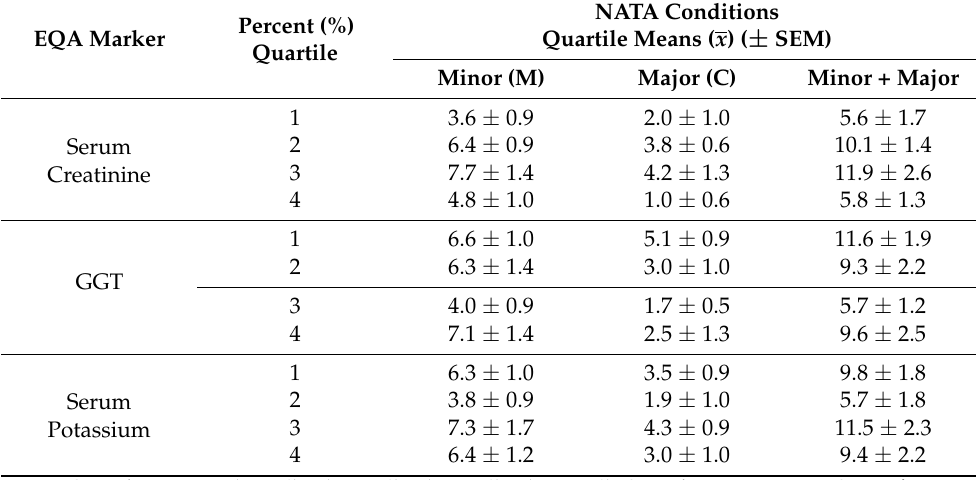
Table 1. EQA quartile (%) rankings of laboratories according to: ( a ) serum Creatinine, ( b ) GGT and ( c ) serum Potassium, and matched with the Mean ( x ) NATA conditions for each quartile (descending from the highest EQA performance to the